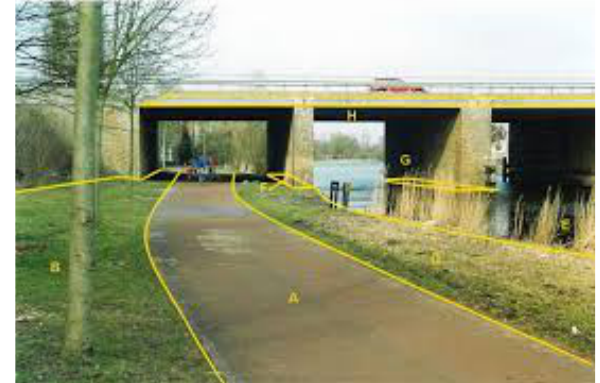
Figure 1: Relative height information as available in the BGT. The bridge (H) is at relative height level ‘1’. The bridge-parts F and G as well as the road, verge and water are at relative height level ‘0’. The latter form a planar partition (IMGeo,